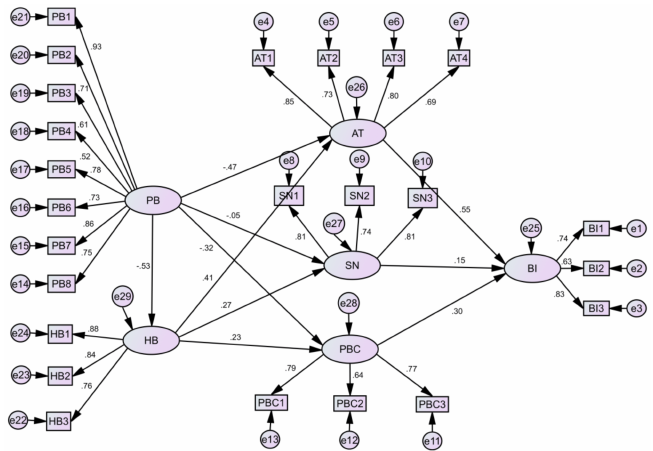
Figure A1. Final structural